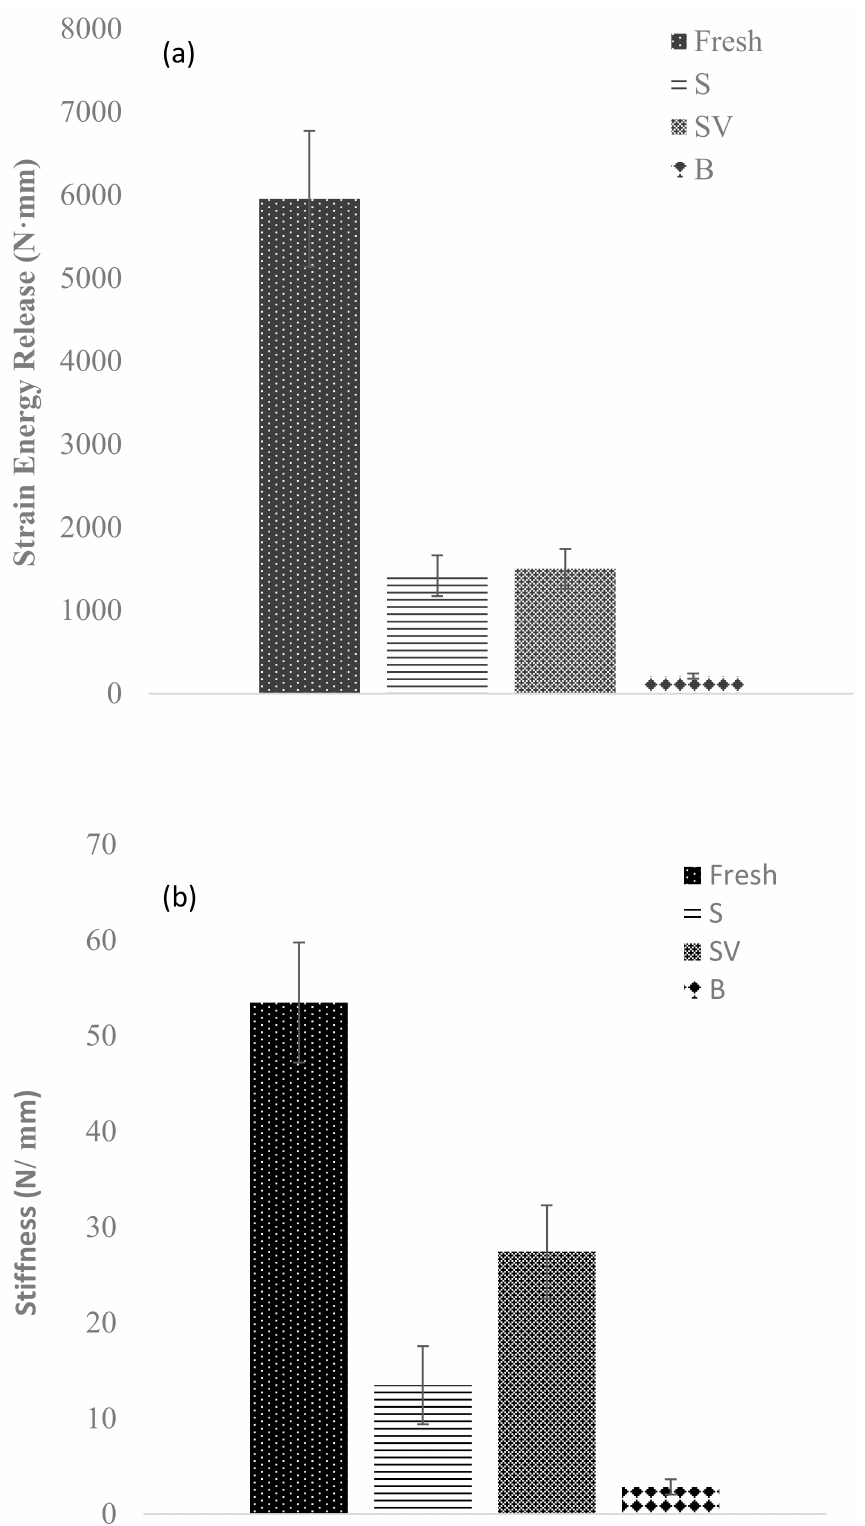
Figure 2. Strain energy release ( a ) and stiffness ( b ) levels corresponding to the untreated (Fresh) and 25-min heated Cheddar samples under steaming (S), sous-vide (SV), and boiling (B). Error bars were calculated from six compression